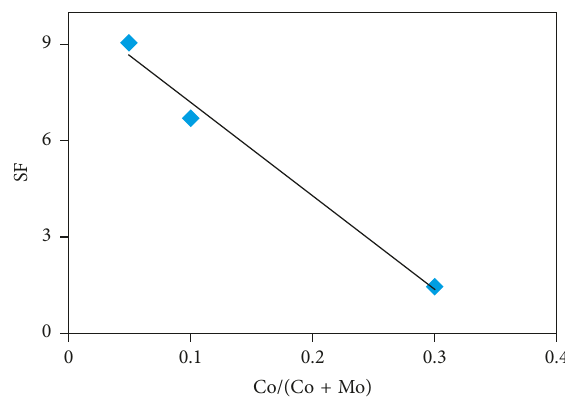
Figure 7: Cobalt content as a function of synergy